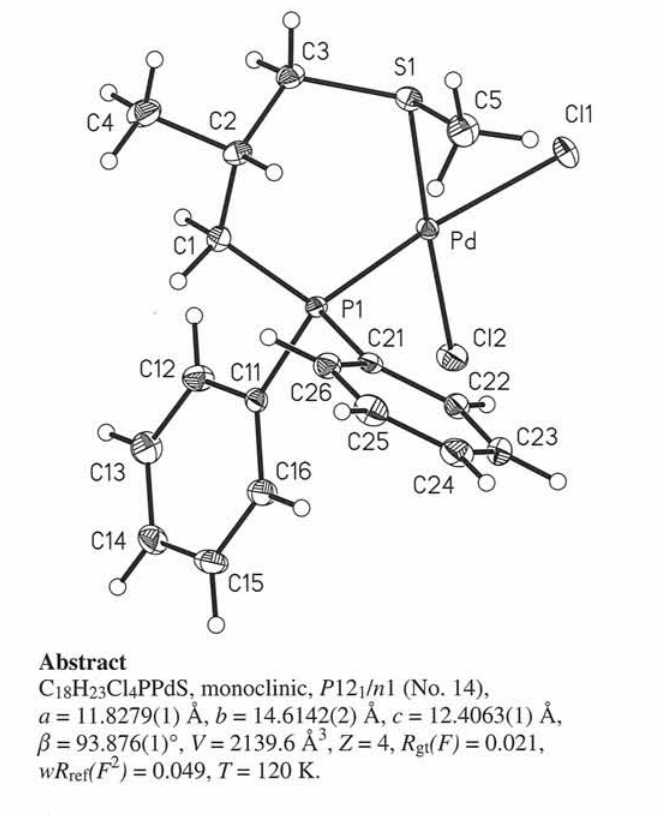
Table 1. Data collection and